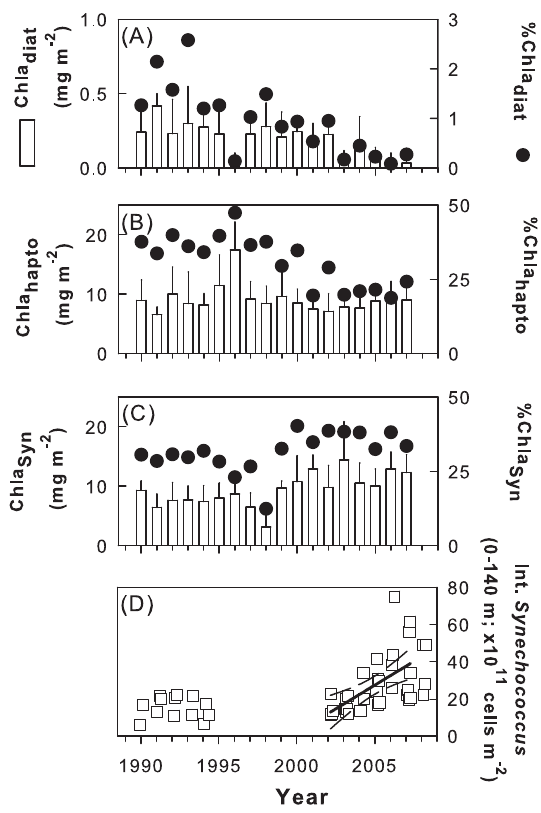
Fig. 3. Time-series of phytoplankton taxonomic groups deter- mined from HPLC pigment analysis as described in the text. (a) diatoms, (b) haptophytes, and (c) Synechococcus . Phytoplankton group biomass estimates (0–140m; mgm − 2 ; open bars) are given as the mean ( ± std. dev.) for January to April of each year and their percent contribution to TChl- a (filled circles). (d) Integrated Syne- chococcus abundances (0–140m; × 10 11 cellsm − 2 ) as determined by direct analytical flow cytometric counts. The solid line through data from 2002 to 2007 is the least squares Model 1 regression, sig- nificant at the P < 0 . 01 level, and predicted 95% confidence intervals (dashed lines). Data from 1991 to 1994 were taken from DuRand et al. (2001), as available on the CD that accompanied the Deep-Sea Res. Pt. II, 48(8/9) in which that data were originally